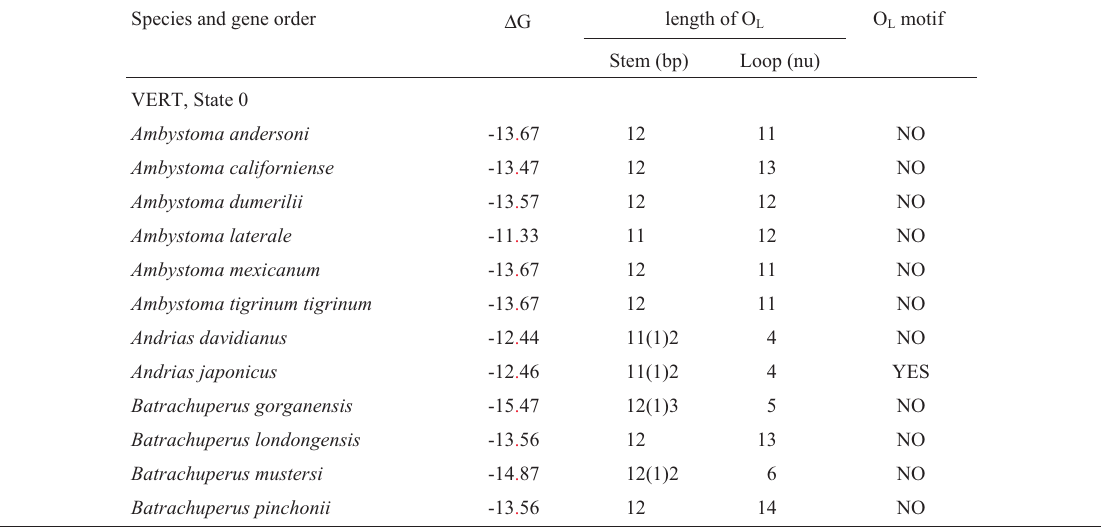
Table 1 - Amphibian taxa (n = 73), gene order, Thermodynamic stability values ( Δ G), length of the L-strand replication origin (O L ) region (stem in base pairs(bp),loopinnucleotides(nu))andthepresenceorabsenceofa5’-GCCGG-3’motifintheO L region.Thespecieswereclassifiedintothreedifferent groups: species with a genome length < 17 kb and a “typical” vertebrate gene order (VERT, state 0); species with a genome length > 17 kb and partial ge- nome duplications (PGD, state 1); or species with gene rearrangements (GRr, state 2). Numbers in parentheses represent the number of internal mis- matches (bp) for the stem or the number of nucleotide mismatches in the internal